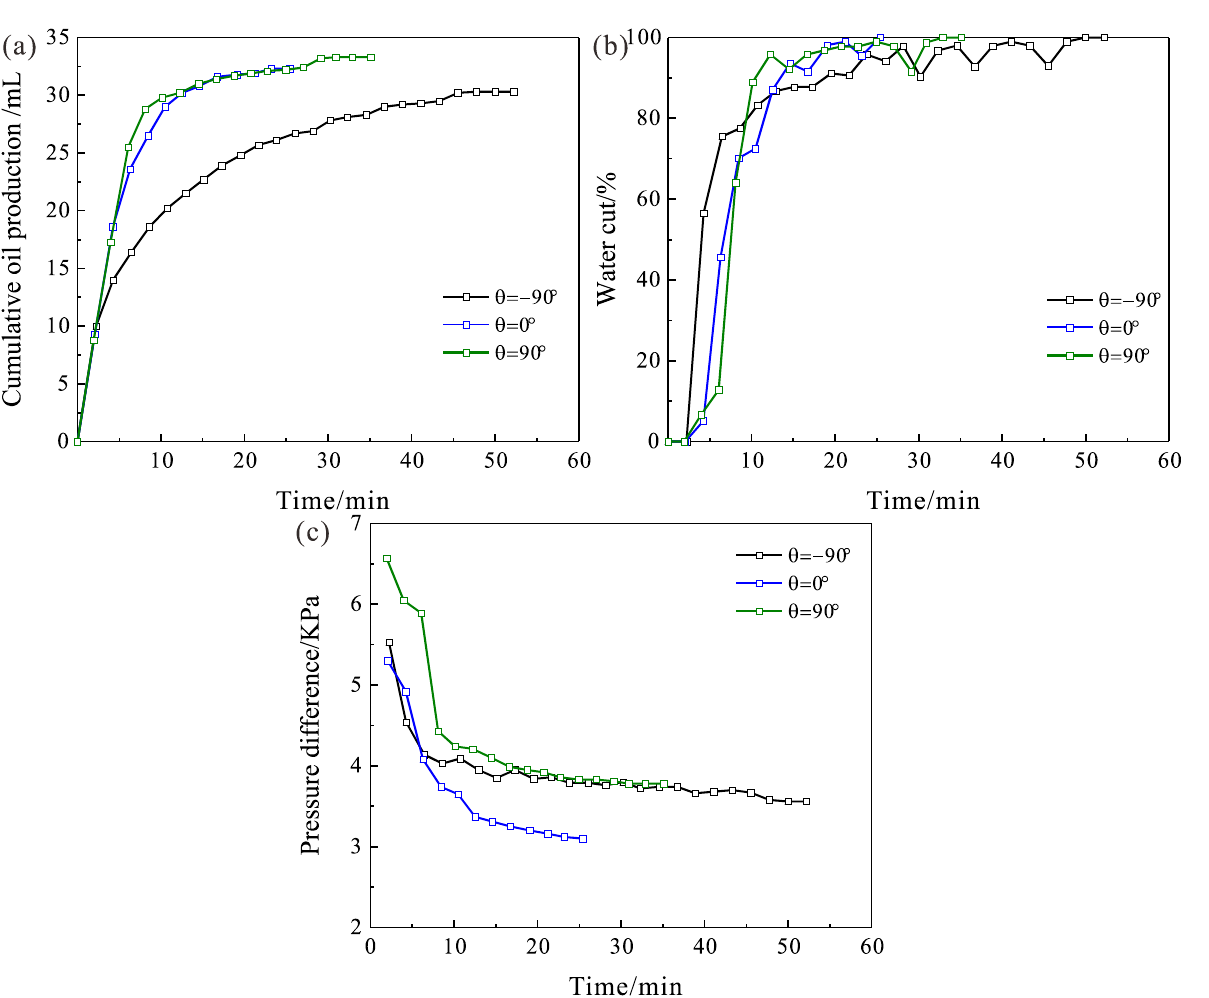
Figure 5. Experiment results in downward ( θ = − 90°), horizontal ( θ = 0°) and upward ( θ = 90°) direction. ( a ) Volume of cumulative produced oil, ( b ) water cut of the production well, and ( c ) pressure drop across the model.